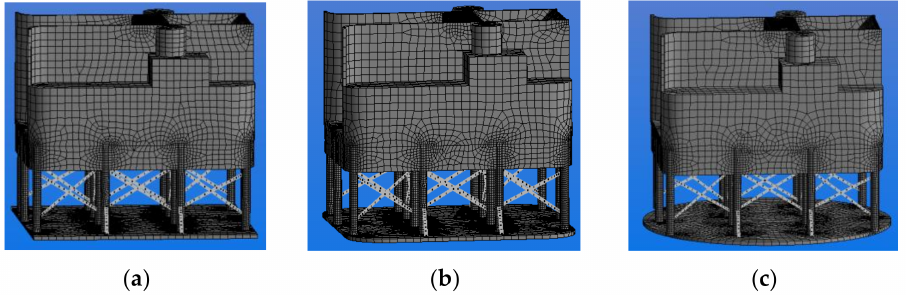
Figure 4. Grid division: ( a ) Scheme 1, ( b ) Scheme 2, ( c ) Scheme